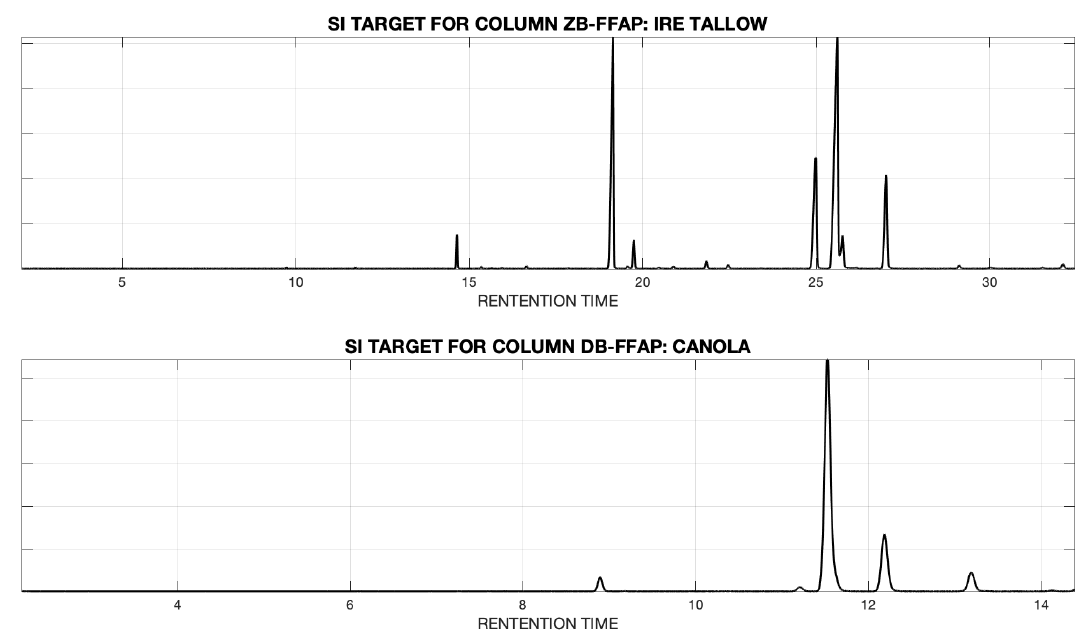
Figure 1. ( top ) Target chromatogram based on similarity index for column ZB-FFAP data; ( bottom ) target chromatogram based on similarity index for column DB-FFAP